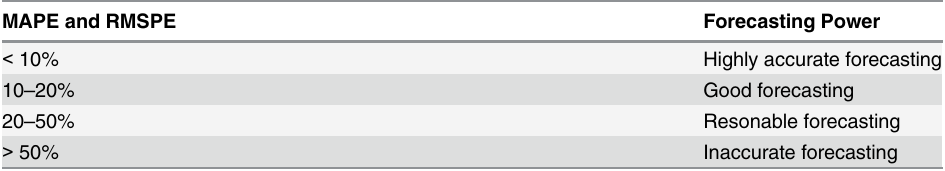
Fig 3. The number of population in Xinjiang from 2003 to 2012. The solid line is the fitted curve of total population number in Xinjiang. doi:10.1371/journal.pone.0138765.g003 Table 4. Criteria of MAPE and